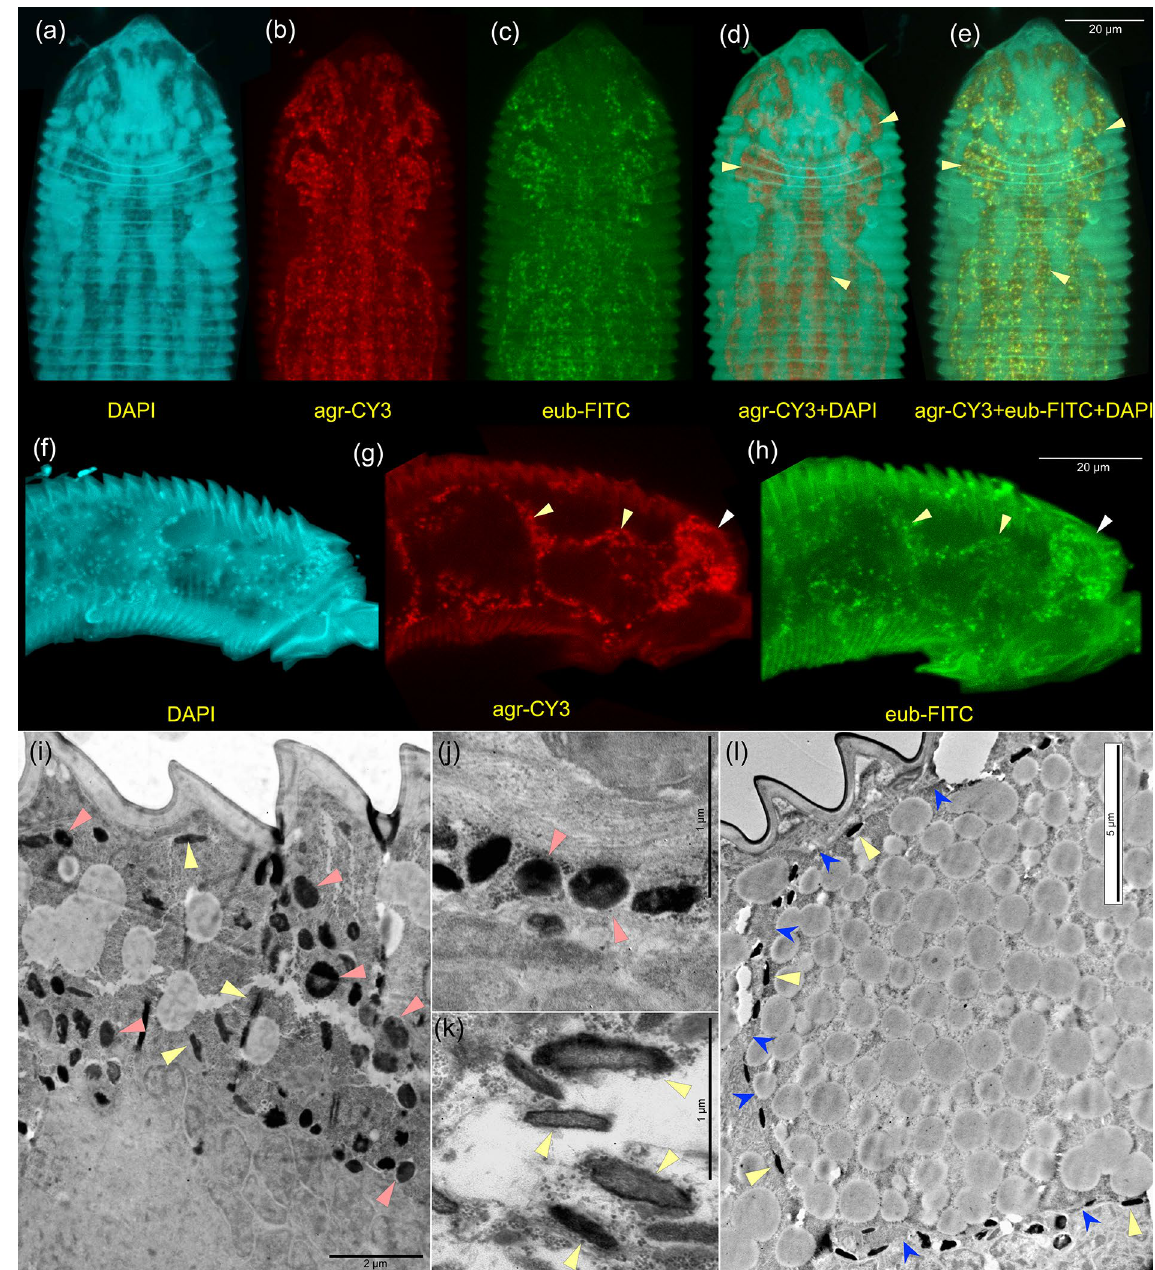
Figure 4. Endosymbiotic bacteria of the mite Fragariocoptes setiger , fluorescence in situ hybridization (FISH) with different fluorophores and oligonucleotide probes ( a–h ) and TEM microscopy ( i–l ). Mite anterodorsal ( a–e ) and anterolateral parts ( f–h ); intermuscular bacteria ( d-e , yellow arrowheads), bacteria surrounding gigantic parenchymal cells ( g , h, yellow arrowheads) and salivary glands ( g , h, white arrowheads); DAPI + no probe ( a , f ); CY3 + 16S.1722F.Agr.tum ( b , g ); FITC + Eub338 ( c , g ); CY3 + 16S.1722F.Agr.tum, DAPI ( d ); CY3 + 16S.1722F.Agr.tum, FITC + eub338, DAPI ( e ). Bacterial morphotype 1 ( Wolbachia ) ( i , j , red arrowheads), and bacterial morphotype 2 (yellow arrowheads) ( k , l , yellow arrowheads) in various locations inside the mite: mid-lateral opisthosoma with saw-like cuticle and underlying tissues are visible ( i ), same as previous, a gigantic parenchymal cell (fat body) is shown and traced by blue arrows ( l ), spaces between the fat body and the gut ( j , k